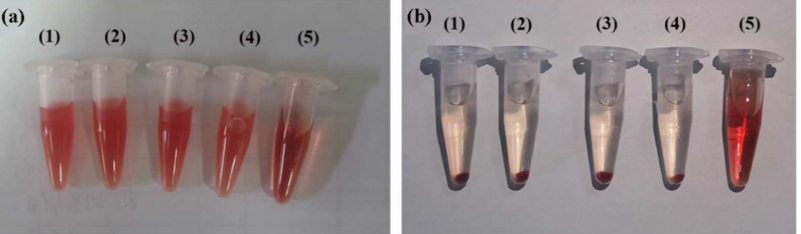
Figure 5. Hemolysis assay. Blood from Sprague–Dawley (SD) rats was centrifuged and washed to obtain red blood cells, incubated with different concentrations of (CP) 6 NS, and centrifuged. ( a ) Before centrifugation and ( b ) after centrifugation. (1) Incubation with (CP) 6 NS at 20 µ g/mL, (2) (CP) 6 NS at 200 µ g/mL, (3) (CP) 6 NS at 500 µ g/mL, (4) saline, and (5)